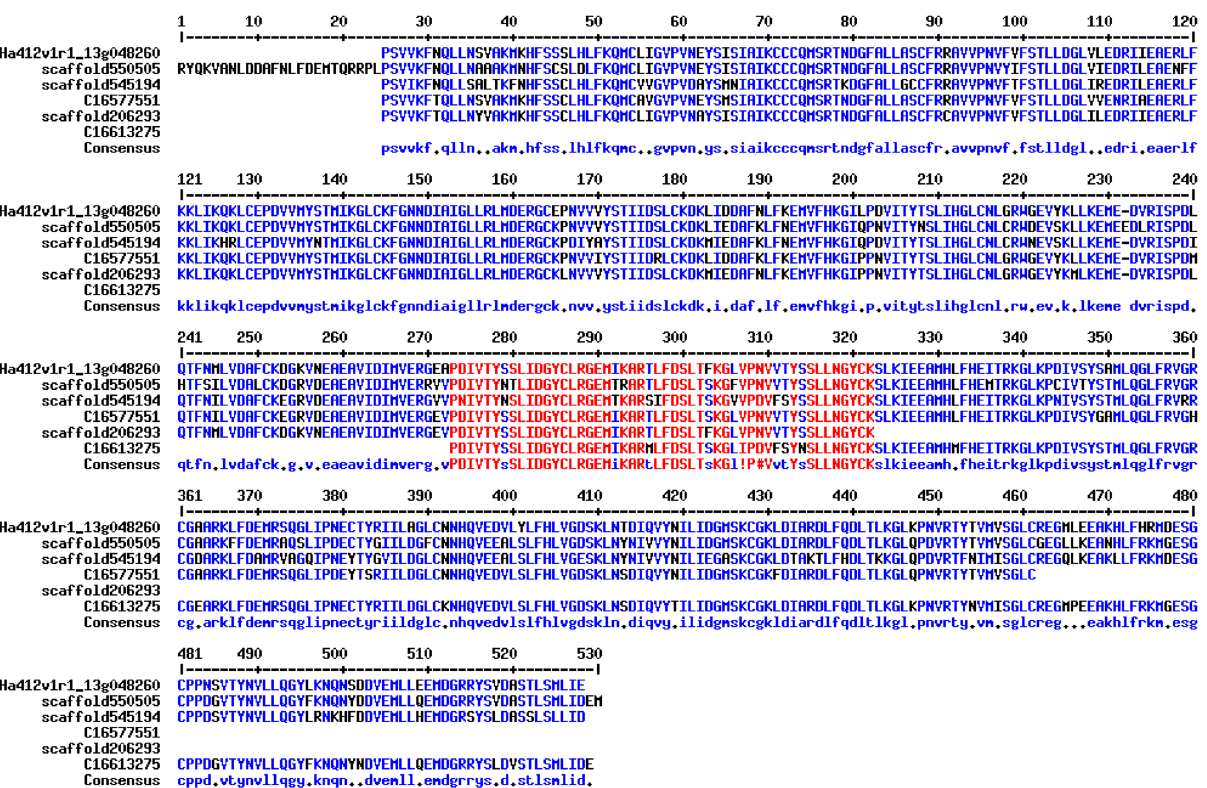
Figure 3. Multiple alignment of amino acid sequences deduced from the best ORFs from two contigs and three scaffolds that are aligned to the Rf5 candidate gene